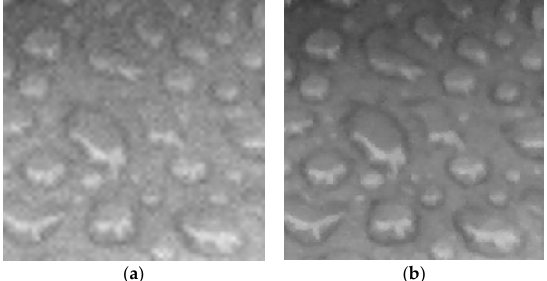
Figure 2. Denoise of the hydrophobicity image. ( a ) The original image; ( b ) After asymptotic semi ‐ soft thresholding.